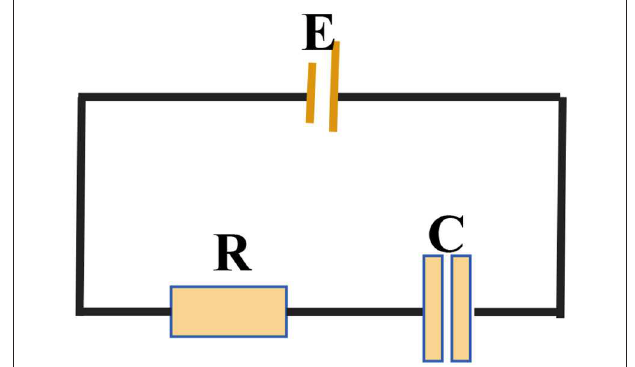
FIGURE 5 | Internal circuit diagram of the proposed real-time on-line sensing system.